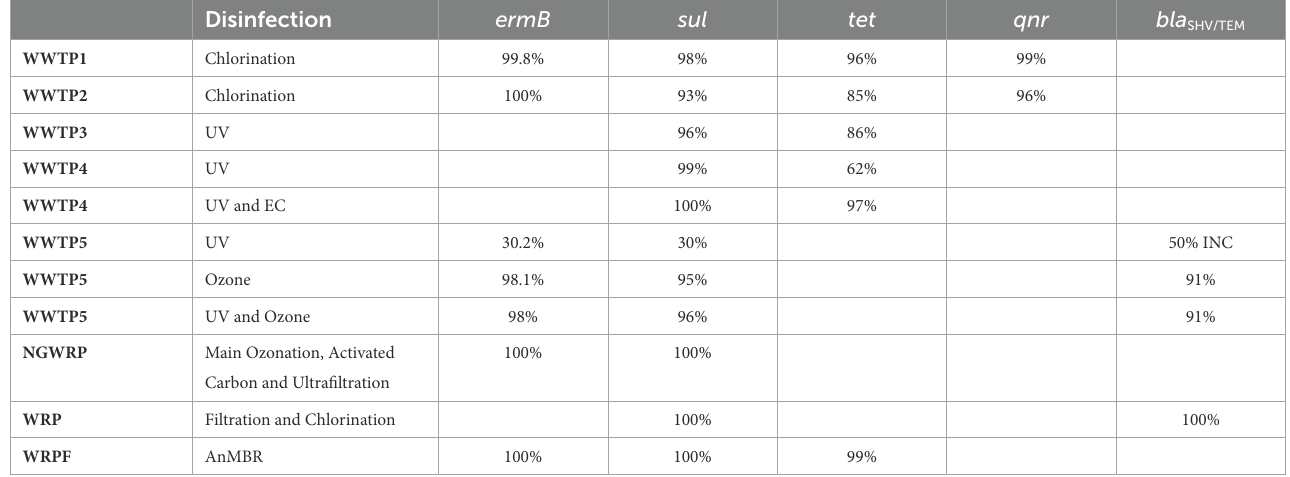
TABLE 5 Removal efficiency of ARGs by different disinfection